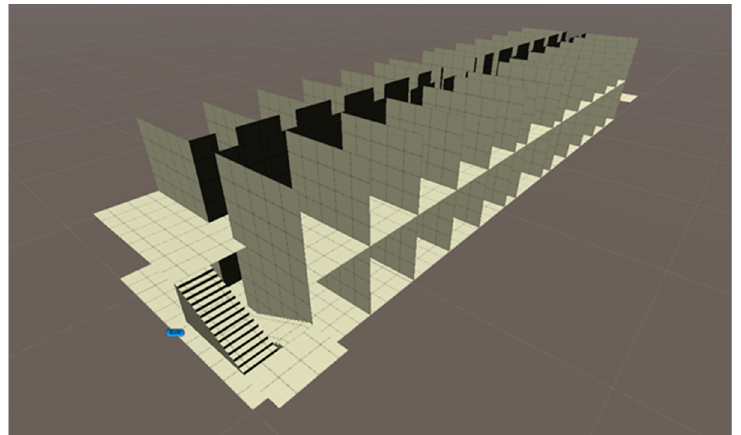
Figure 8. Three-dimensional model of the evacuation space.